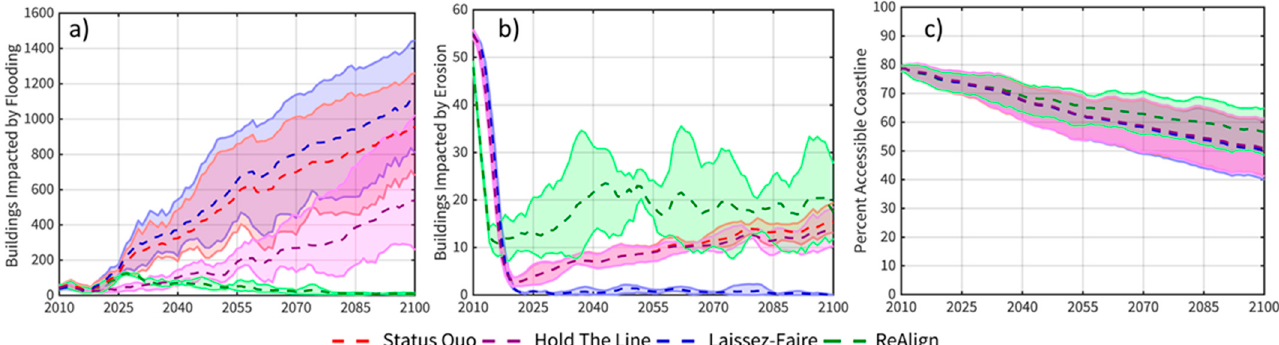
Figure 11. Three landscape performance metrics (buildings impacted by flooding, ( a ); buildings impacted by erosion, ( b ); beach accessibility, ( c ) compared across four policy scenarios under a range of climate scenarios. Dashed lines indicate the mean of the medium-impact climate scenarios. Shading indicates the mean of the low- and high-impact climate scenarios.